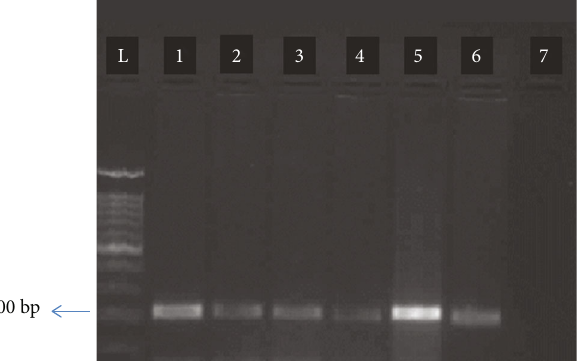
Figure 2: PCR results in the mouse brain (pilot groups): L: ladder 1000 bp; 1 and 5: positive controls ( Toxoplasma tachyzoites); 2, 3, 4, and 6: samples; 7: negative